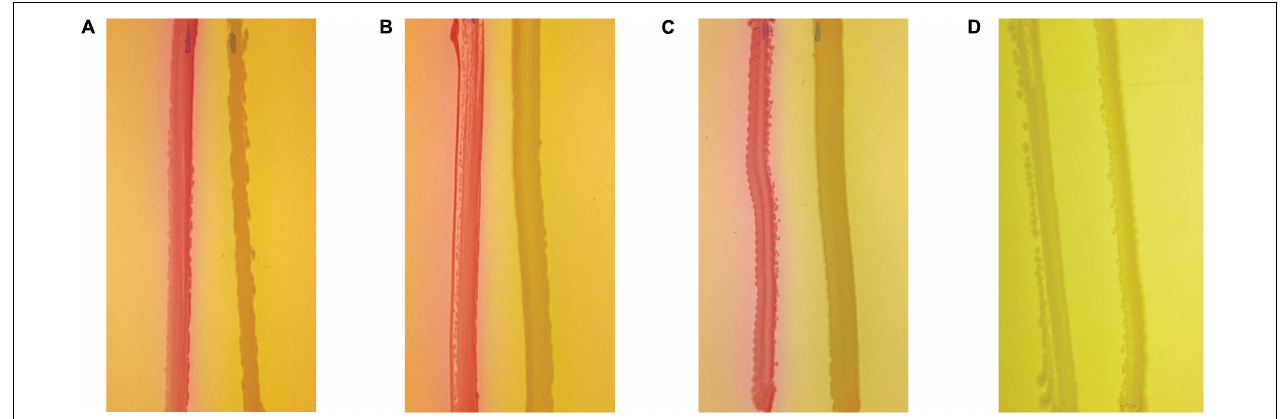
FIGURE 6 | PmtA does not affect acyl homoserine lactones levels. Wild-type (A) , (cid:49) pmtA (B) , and (cid:49) pmtA : pmtA (C) . PAO1 (D) E. coli MC1061 strains were streaked out on MacConkey agar plates 0.75 cm apart from E. coli strain MG4. In the presence of AHL, lasR initiates the transcription of LasB-LacZ fusion protein resulting in beta-galactosidase in MG4, this causes colonies to change color from white to pink. All three strains caused the color change to pink suggesting that QS mediated by AHL is not inhibited by the absence of PmtA.